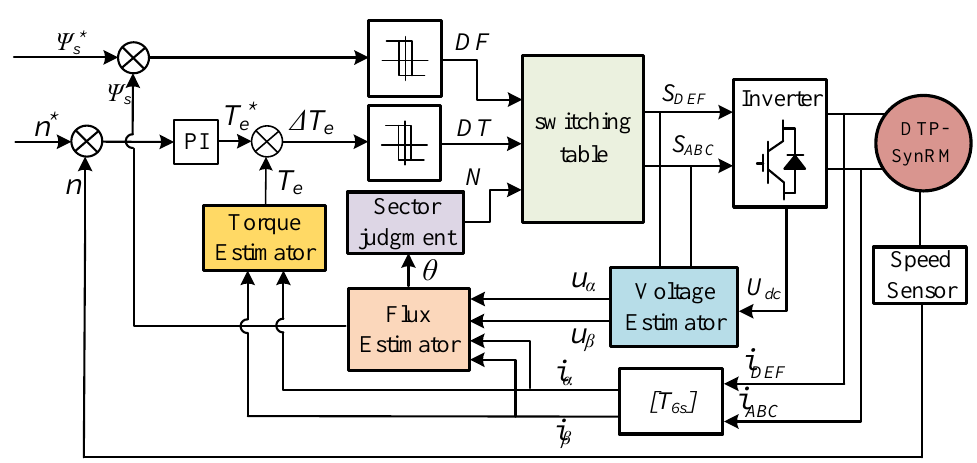
Figure 8. Principle block diagram of DTC of DTP-SynRM.